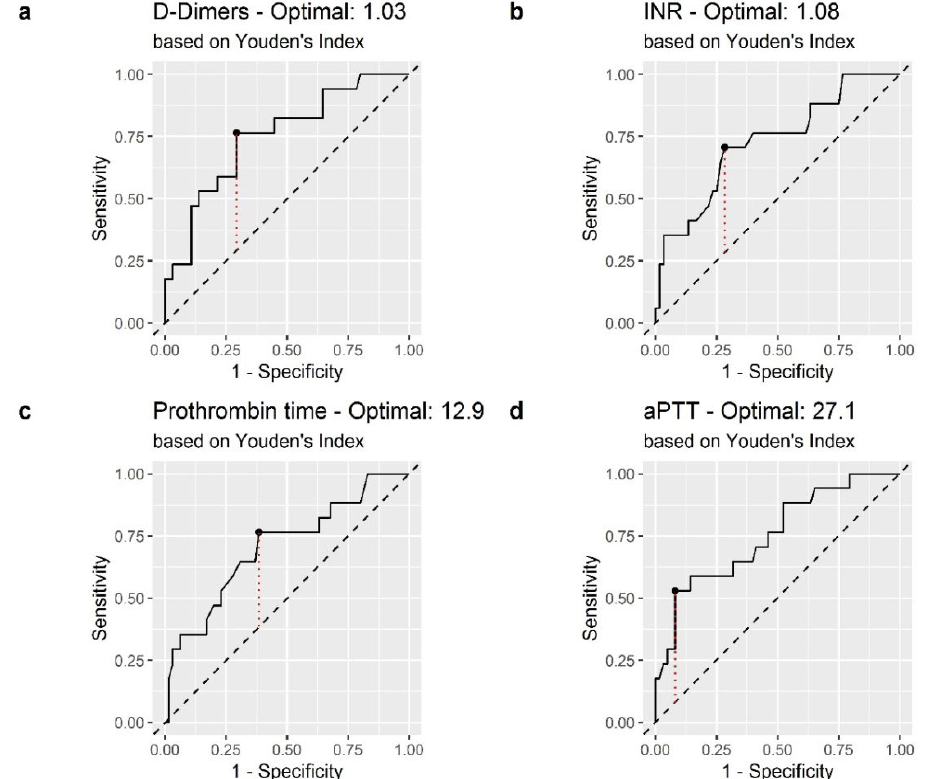
Figure 2. Receiver operating characteristic (ROC) curve of coagulation biomarkers in the prediction of in-hospital mortality: ( a ) D-Dimer; ( b ) International Normalized Ratio (INR); ( c ) Prothrombin Time (PT) ( d ) Activated Partial Thromboplastin Time (aPTT). The dashed red line represents the Youden index.